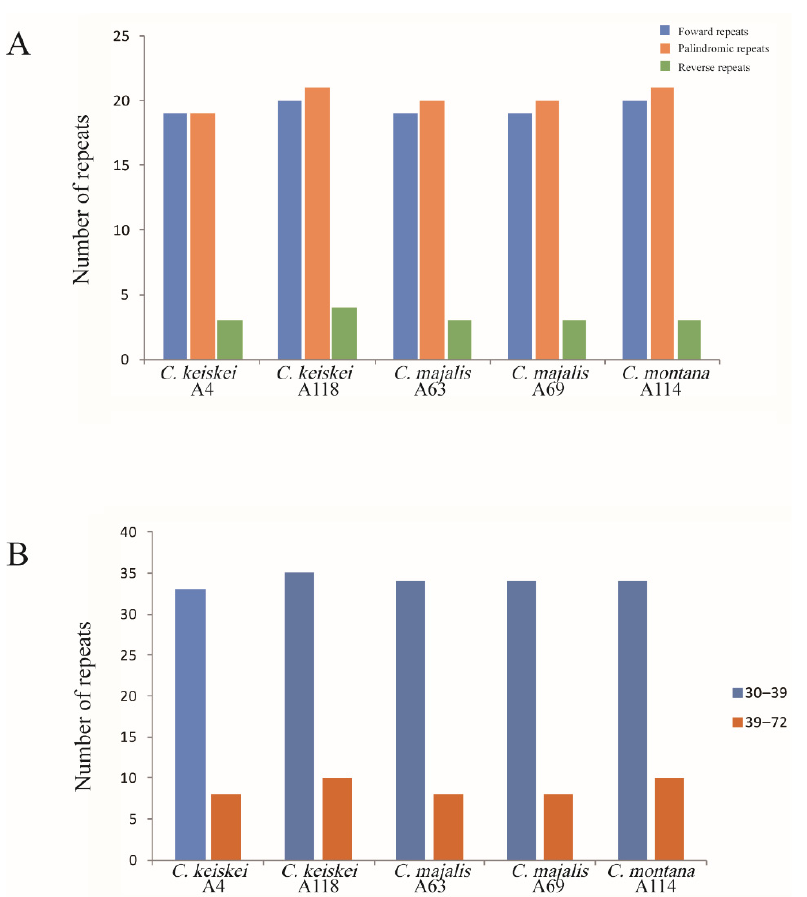
Figure 5. Repeat sequences analysis in five Convallaria chloroplast genomes. ( A ) Frequency of repeat types. ( B ) Frequency of repeats by length.